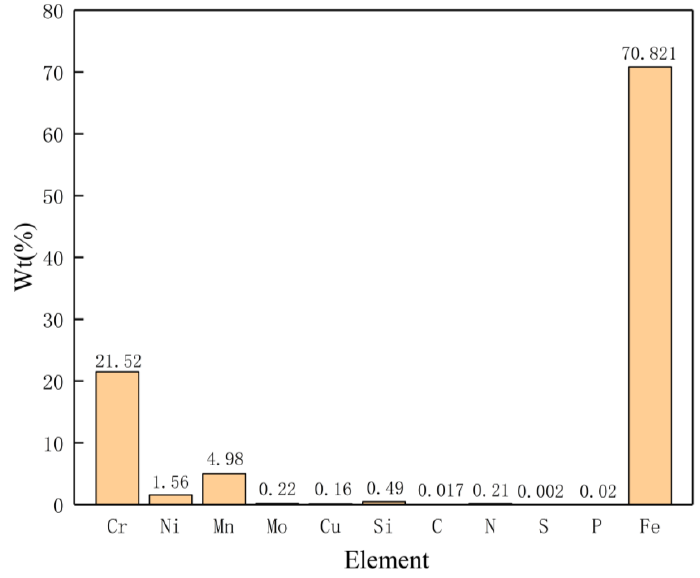
Figure 1. Chemical composition of the S32101 DSS plate. Table 1. Welding